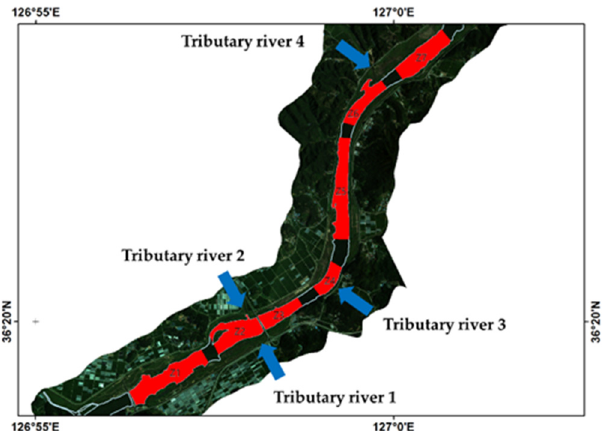
Figure 4. Map of the cyanobacteria distribution divided into seven sections according to the hydrodynamic conditions and tributary rivers.